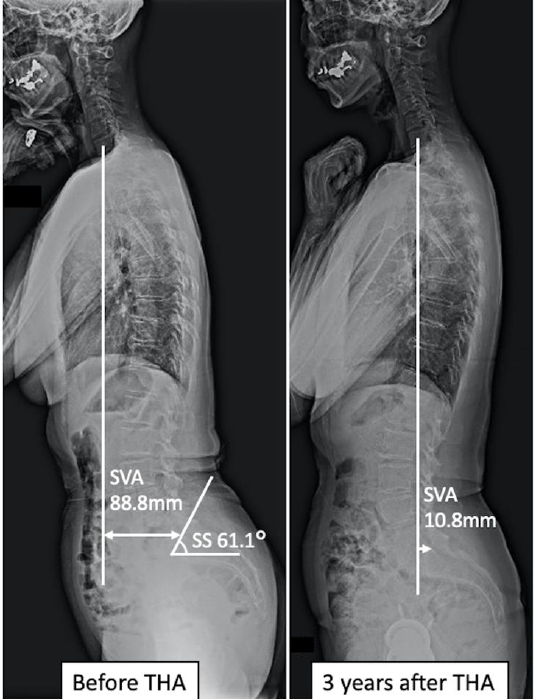
Figure 4. A case with improved spinal sagittal balance after total hip arthroplasty. Preoperatively, the sacral slope, sagittal vertical axis (SVA), and abdominal trunk muscle strength were 61.1°, 88.8 mm, and 5.2 kPa, respectively. Postoperatively, SVA decreased to 10.8 mm.